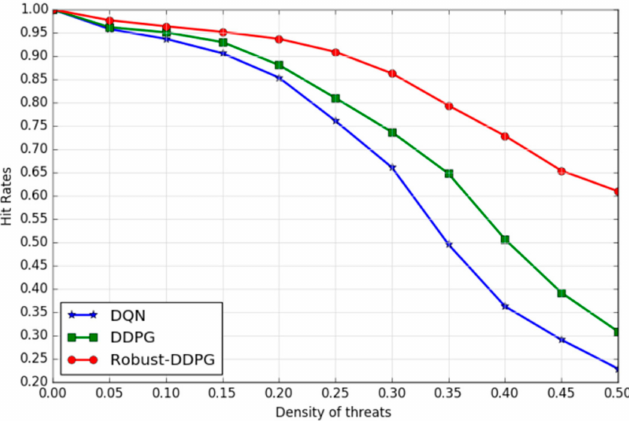
Figure 9. Environments with di ff erent threat densities.